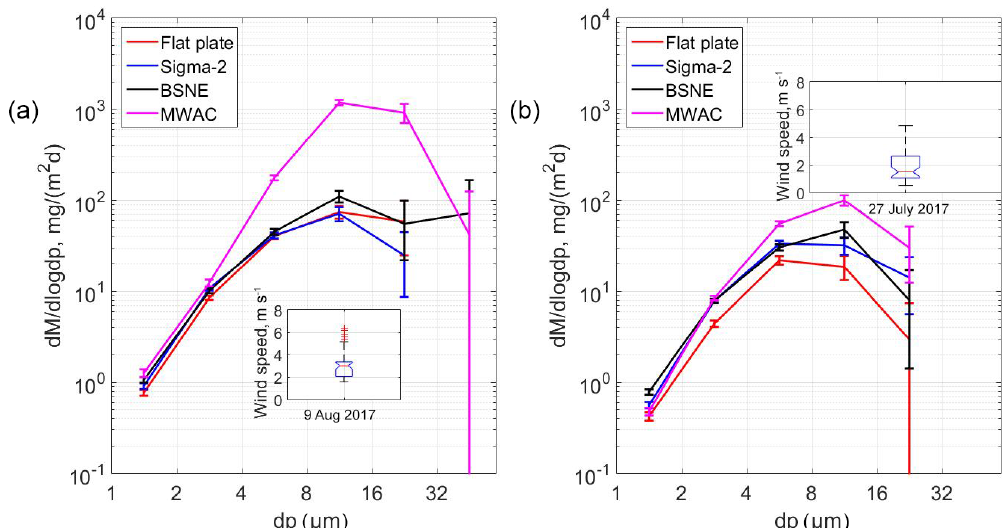
Figure 5. Size-resolved mass deposition rate measured by different passive samplers: (a) dust event day; (b) non-dust event day. Data are derived from SEM measurements. The bars show the central 95% confidence interval of the daily variation. The inserts show box plots for the wind speed distribution based on 30min intervals.